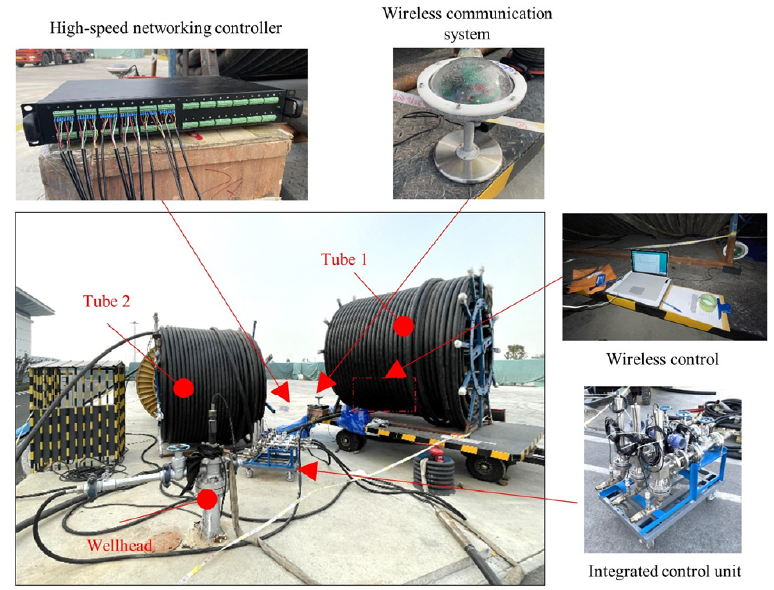
Table 1. Two-layer stratified water injection test conditions.